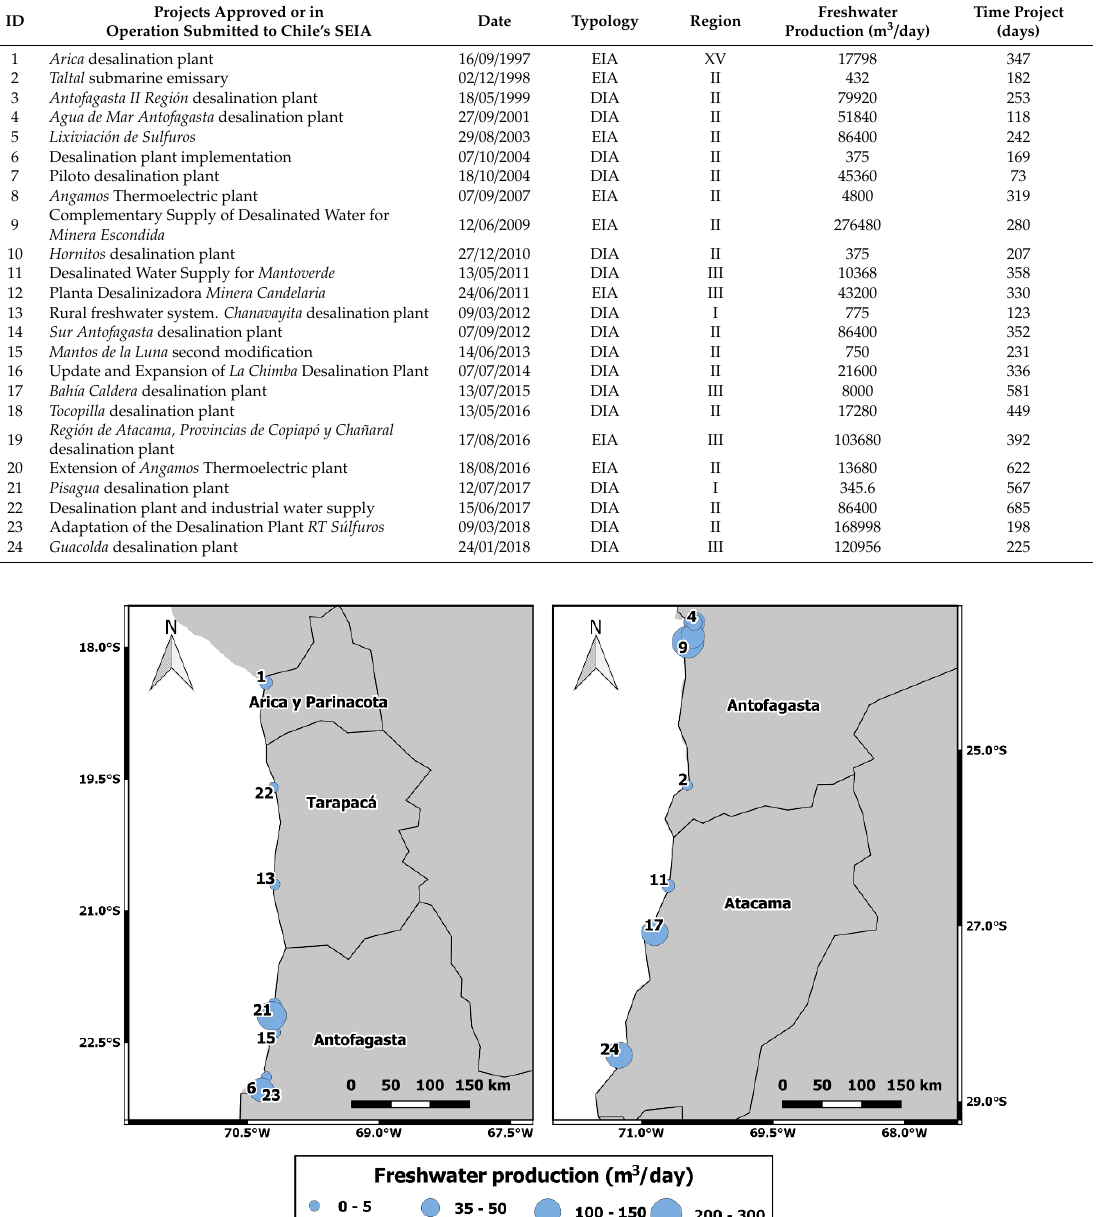
Table 1. Publications of desalination projects approved by Chile’s SEIA.